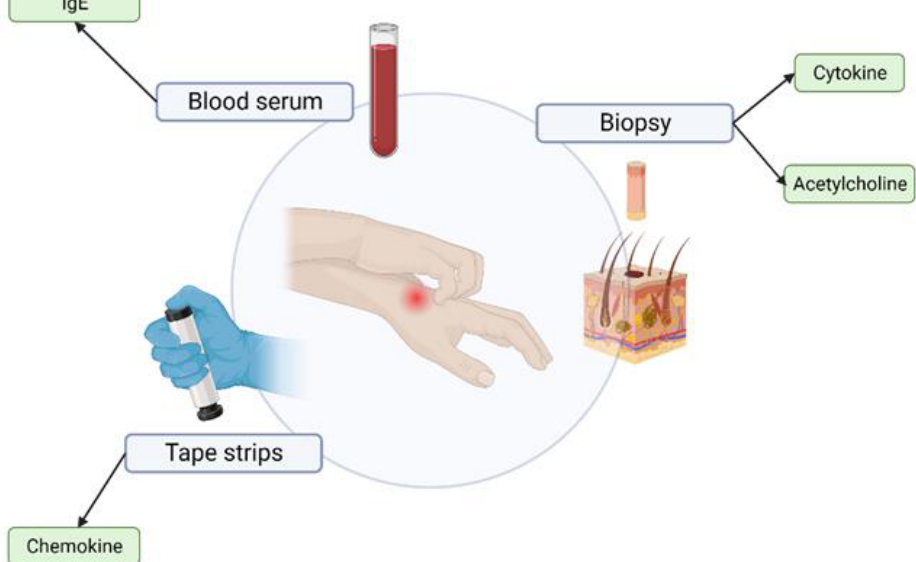
Figure 1. Methods of medical examination of AD and their corresponding potential biomarkers. The three main empirical methods are listed, all of which are performed under a controlled clinical en- vironment. Figure created with BioRender.